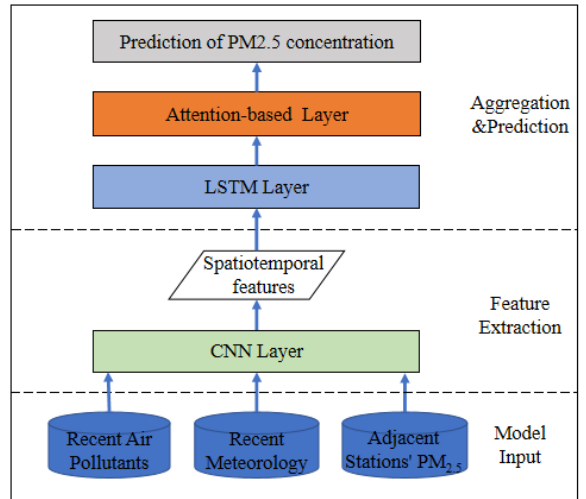
Figure 1. Framework of the proposed approach.